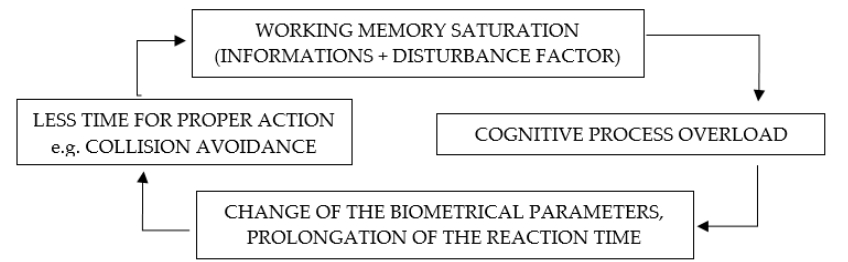
Figure 2. Information saturation with disturbance factor cause typical change of biomarkers.